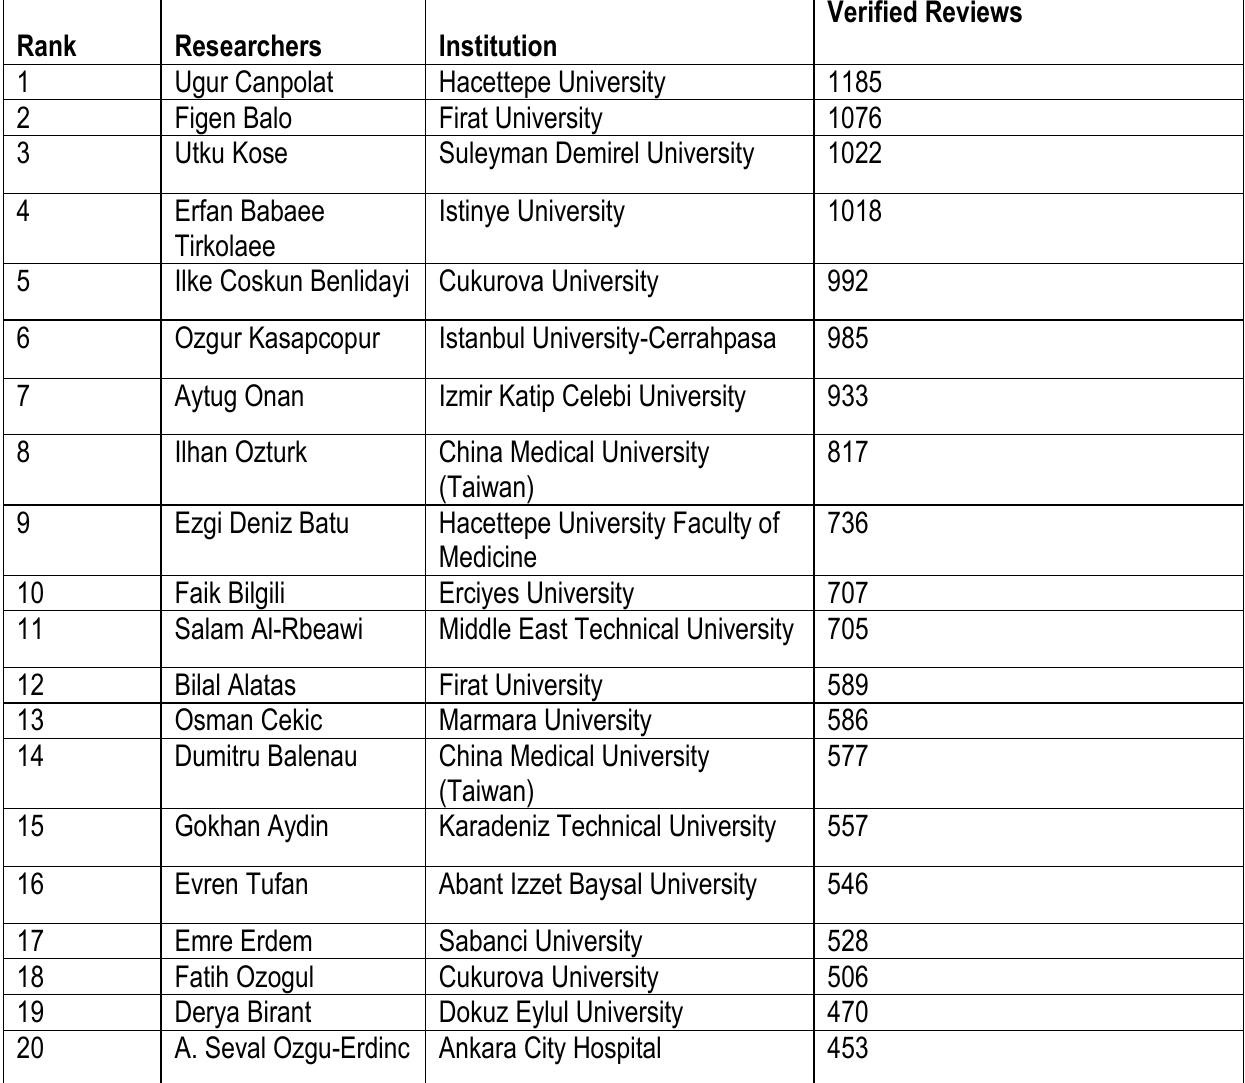
Table 2. Top 20 researchers in terms of the total number of verified reviews